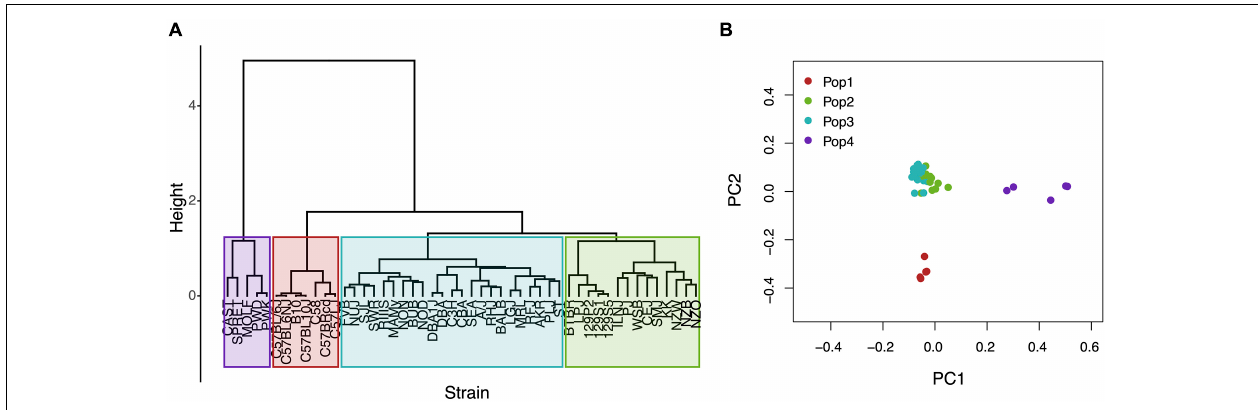
FIGURE 1 | An analysis of population structure among 49 inbred mouse strains, which is based upon whole genome sequence analysis, identifies four sub-populations. (A) The relatedness of the 49 inbred strains based upon hierarchical clustering using an identity-by-state similarity matrix; or (B) a scatter plot generated by PCA using the first two PCs for each strain are shown. The sub-populations identified by the two methods are completely concordant. Sub-populations 1 and 4 are distinct from the majority of the inbred strains that contained in two closely related sub-populations (2 and 3).